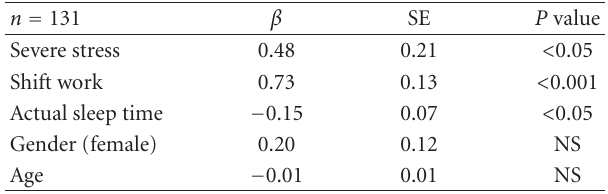
Table 2: Associations of the studied items with the ratio of salivary cortisol level 60 minutes (T1) after awakening to salivary cortisol level immediately (T0) after awakening (T1/T0